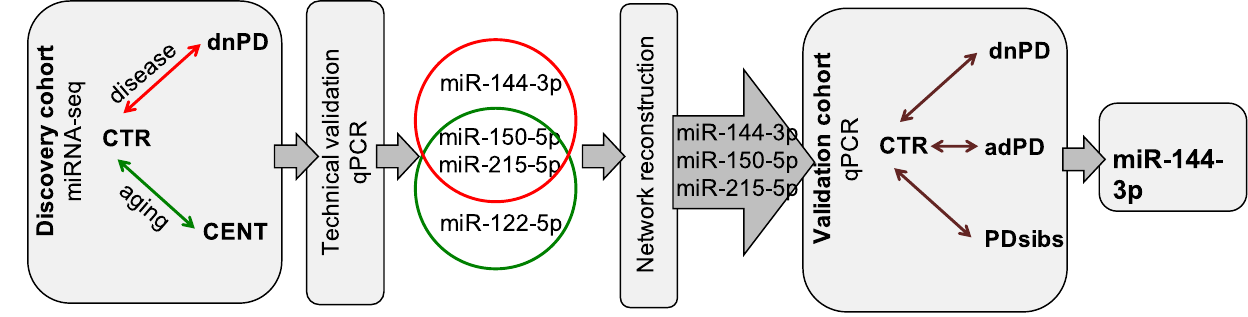
Figure 5. Summary of the overall experimental design and results pipeline. The figure was drawn using Microsoft Office 2016, Power Point. (https:// www. micro soft.